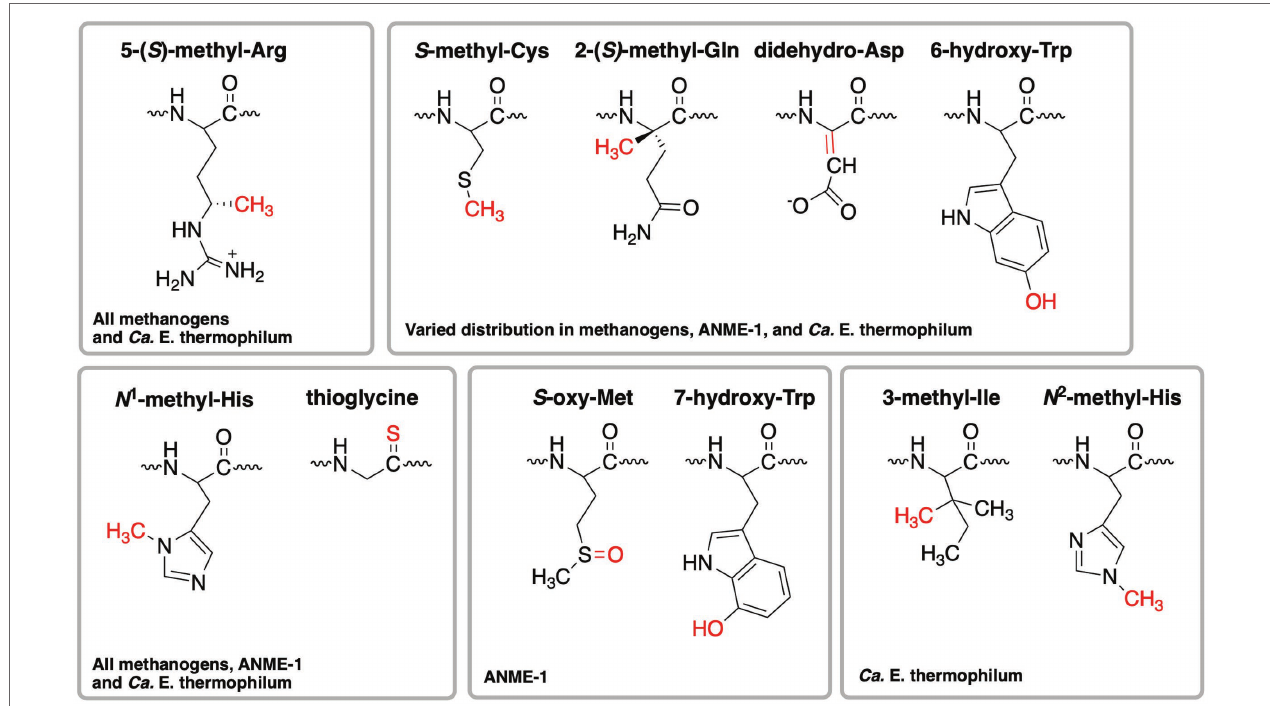
FIGURE 3 | Structures of post-translational modifications identified in the active sites of various MCRs and ECR. The distribution of these PTMs is further summarized in Table 1